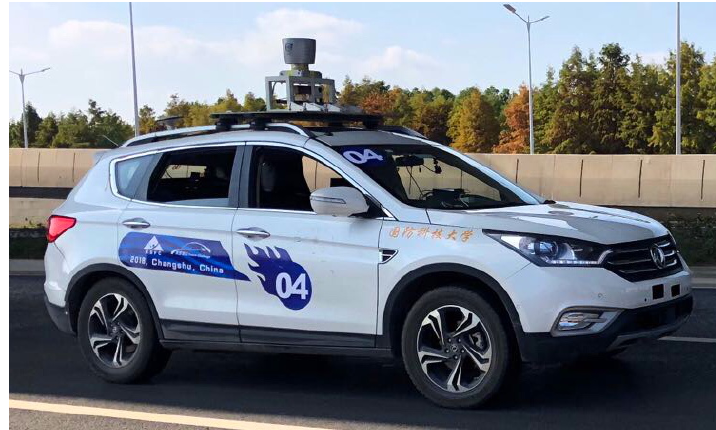
Figure 6. Our experimental platform. It is equipped with a Velodyne HDL-64E Lidar, a Xsens MTI300 IMU, two photoelectric encoders, a NovAtel SPAN-CPT GNSS/INS system, and a Nova 5100 industrial